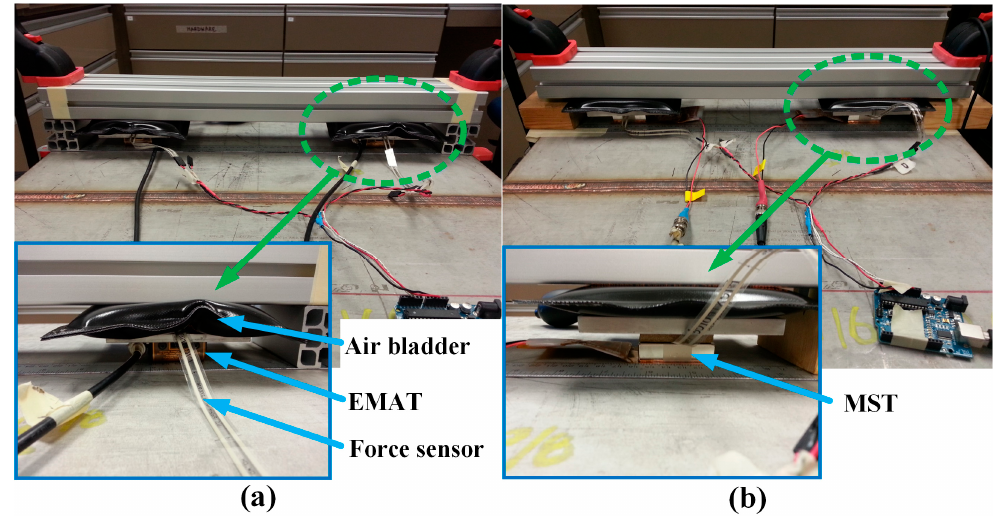
Figure 8. Photos of: ( a ) the EMAT; and ( b ) MST test setup on a stainless steel plate for analyzing the effect of normal force applied on the transducers on SH wave measurements.